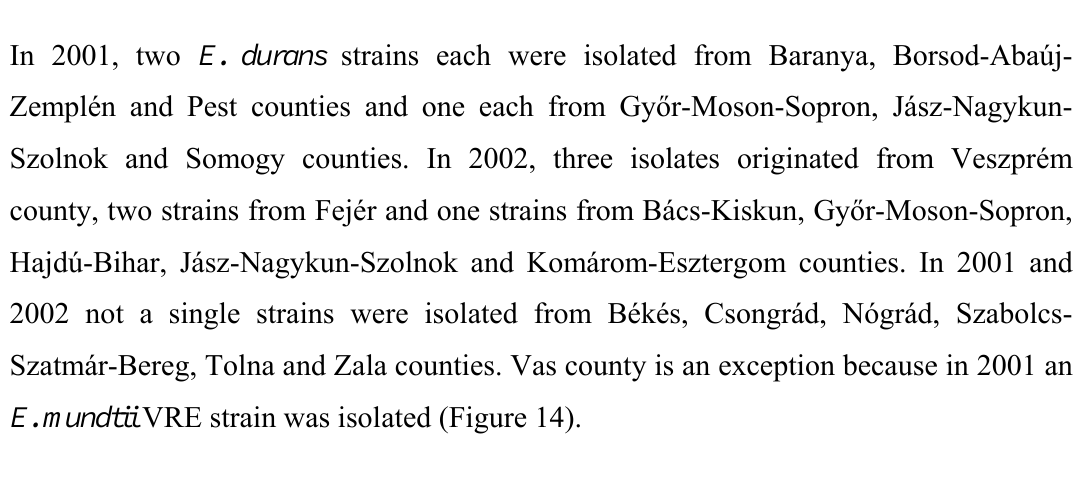
Figure 13. Source of the Hungarian vancomycin-resistant Enterococcus faecium strains at county level in 2001 (n=10) and 2002